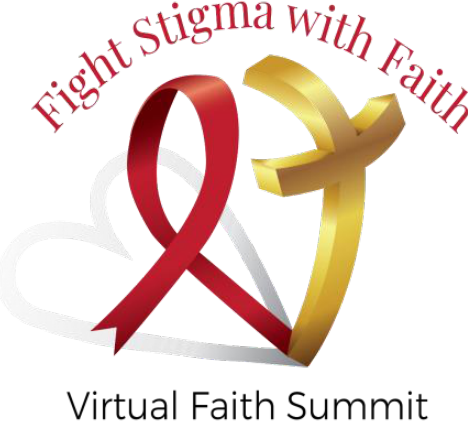
Figure 2. Project Figure 2. Project Logo .